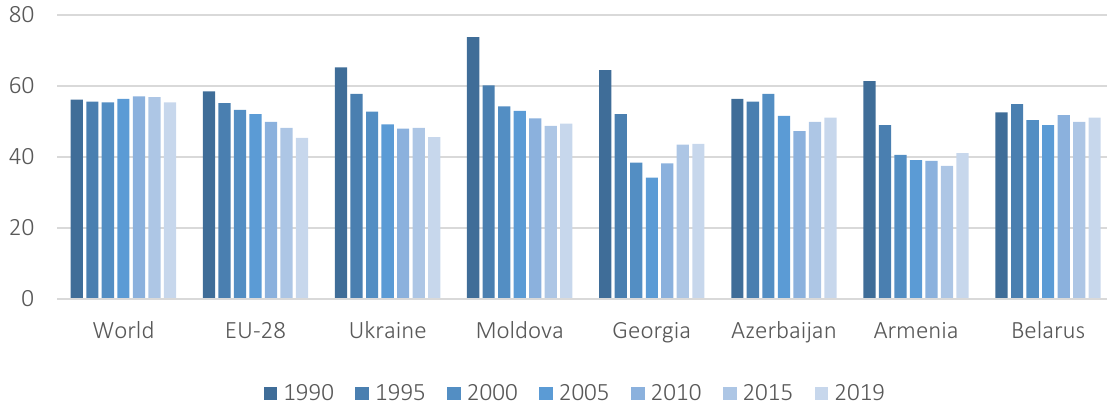
Figure 10. CO2 intensity of energy mix (CO2/TES),